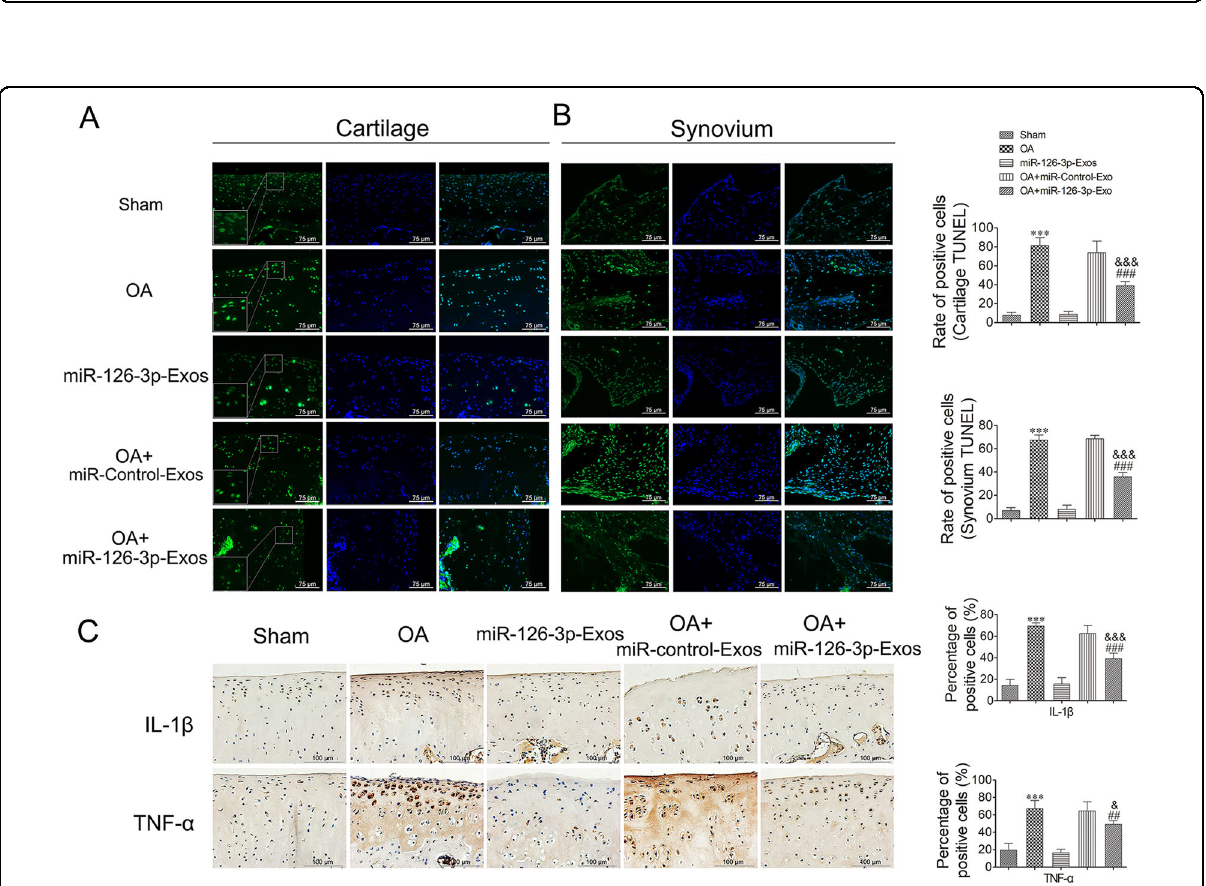
Fig. 5 SFC-miR-126-3p-Exos suppress synovial in fl ammation-mediated cartilage degeneration. Sections of articular cartilage and synovium ( n = 5 for each group) were stained using H&E staining. Those OA model rats treated with SFC-miRNA-126-3p-Exos exhibited increased surface regularity and articular cartilage thickness, and alleviate synovial in fl ammation.